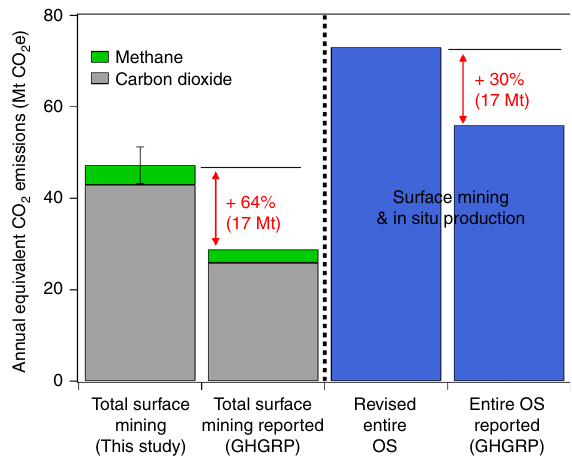
Fig. 4 Total oil sands (OS) annual greenhouse gas (GHG) emissions compared to those reported to the GHG reporting program. Methane emissions from Baray et al. 12 are added to the surface mining CO 2 measured here, to be comparable to reported CO 2 e . A global warming potential (GWP) of 25 is used for methane. Blue bars include in-surface and in situ OS extraction. Revised estimate for total OS emissions includes the measured surface mining emissions determined in this study and the reported emissions from in situ operations. Errors associated with annual CO 2 (Fig. 2b) and CH 4 estimates have been added in quadrature: ffiffiffiffiffiffiffiffiffiffiffiffiffiffiffiffiffiffiffiffiffiffiffiffi þ δ 2 δ 2 CO 2 CH